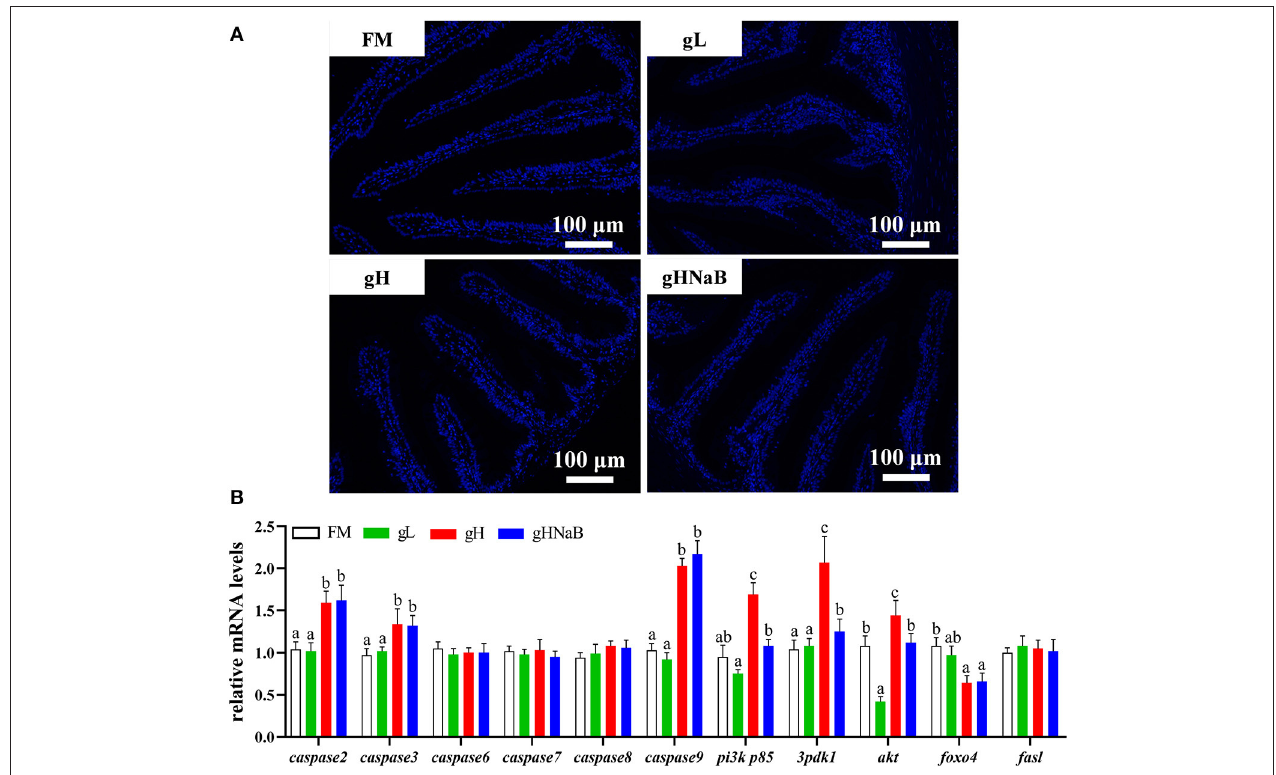
FIGURE 3 | Effects of different treatments on the TUNEL staining (A) and mRNA levels of apoptosis-related genes (B) , including caspase2 , caspase3 , caspase6 , caspase7 , caspase8 , caspase9 , pi3k p85 , 3pdk1 , akt , foxo4, and fasl in the distal intestine of hybrid grouper. Values were means of eight replicates ( n = 8) and were represented as Mean ± standard error. a,b,c Mean values with unlike letters were significantly different ( P <